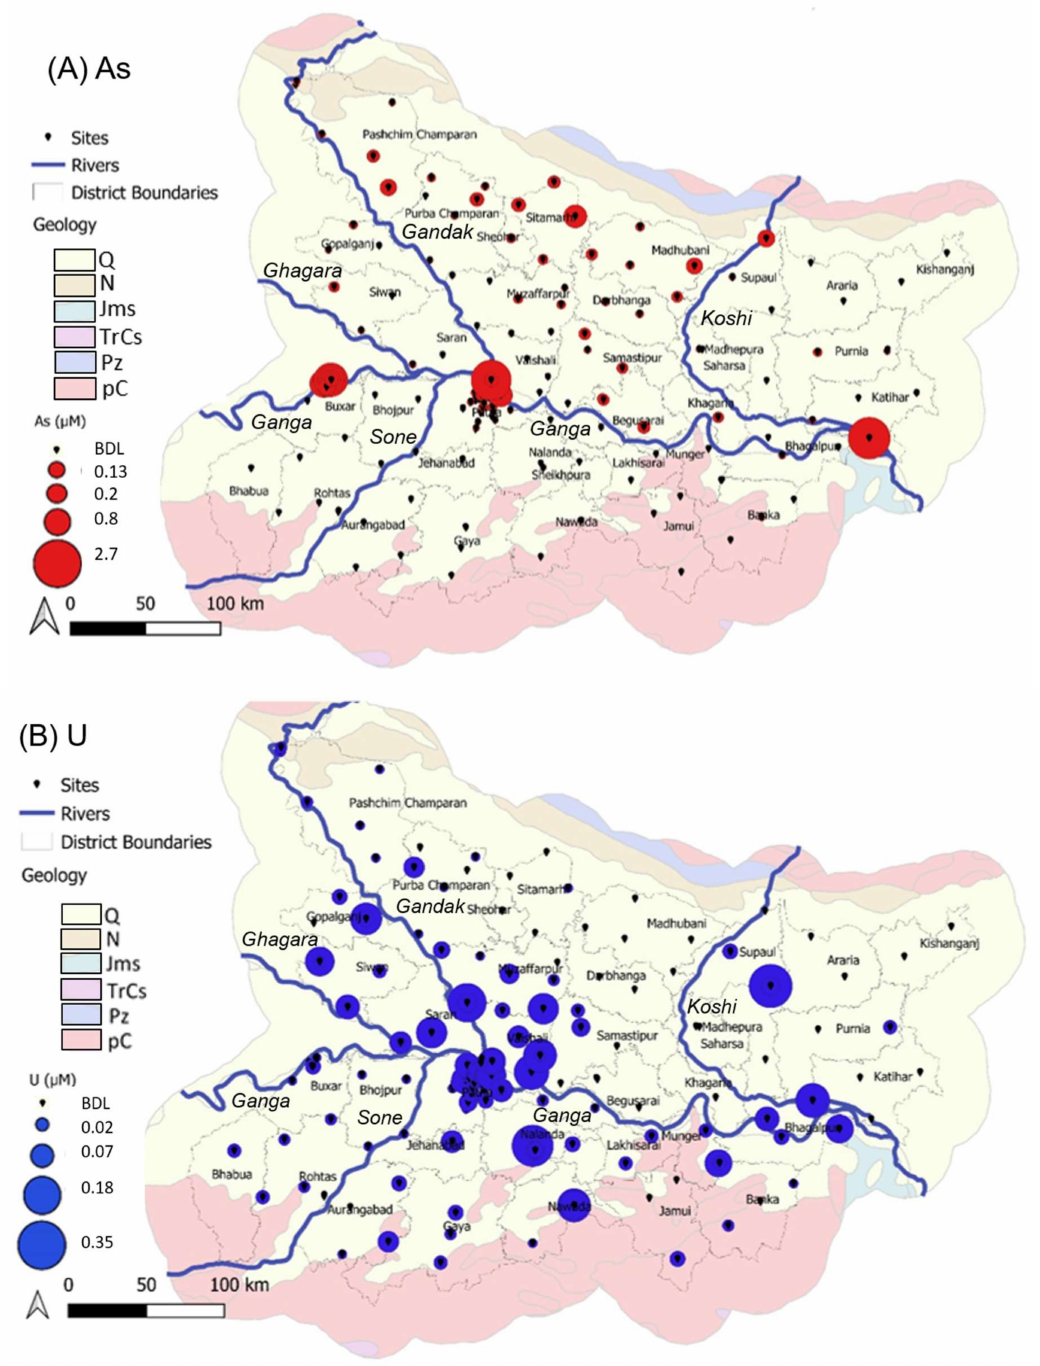
Figure 6. Spatial distribution of ( A ) As and ( B ) U in Bihar. Layers from Natural Earth and the US Department of Interior. Geochronological categorization: Q = Quaternary; N = Neocene; Jms = Jurassic; TrCs = Triassic carboniferous; Pz = Paleozoic; pC = Pre-Cambrian. BDL = below detection limit (0.01 µ M for As and 0.004 µ M for